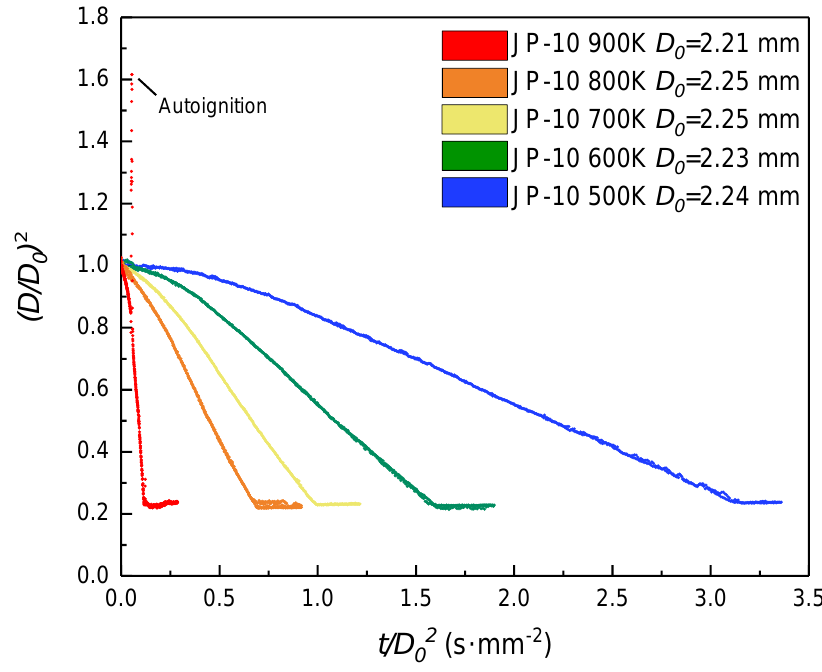
Figure 6. Evolution of droplet diameter square for JP-10 droplets at 500 – 900 K.